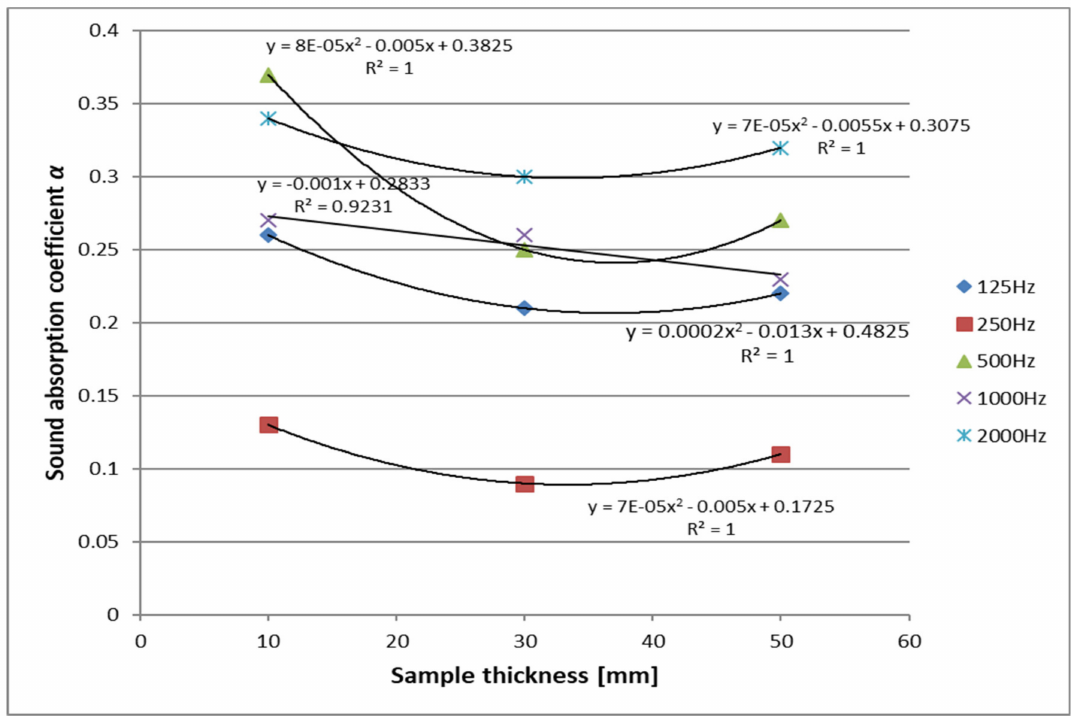
Figure 11. Sound absorption coefficient dependence on the thickness of the sample of comparative mixture (the trendline is reported for each set of